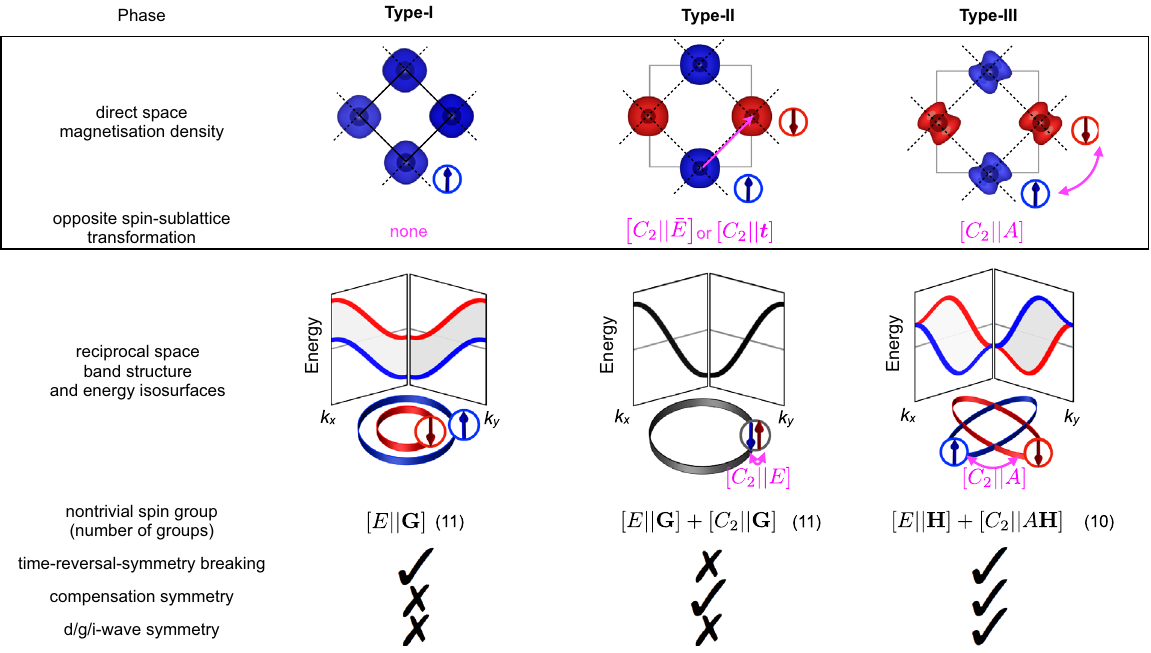
FIG. 1. Illustration (incolumns)ofthe three nonrelativisticcollinearmagneticphases.Topbox:Illustrative collinearspinarrangementsand magnetization densities on crystals. Opposite spin directions are depicted byblue and red color. Spin arrows are placed outside the real-space cartoons to highlight that the overall spin axis orientation is not related to the real space coordinates for the nonrelativistic spin-group symmetries. 1st magnetic phase (conventional ferromagnetism) crystal corresponds to Fe, 2nd magnetic phase (conventional antiferromag- netism) to MnPt, and the 3rd unconventional magnetic phase (altermagnetism) to RuO 2 . Magenta arrow and magenta label highlight opposite-spin-sublattice transformation symmetries characteristic of the 2nd magnetic phase (real-space translation or inversion) and the 3rd magnetic phase (real-space rotation). Bottom box: Cartoons of band-structures and corresponding energy iso-surfaces show ferromagnetically spin-split bands (opposite spin states depicted by blue and red color), a spin-degenerate antiferromagnetic band, and bands in the 3rd magnetic phasewith alternating sign of the spin splitting. The opposite-spinsublattice transformation of the spin Laue group whichmapsthesame-energyeigenstateswithopposite spins onthesame k -vector inthe 2ndmagnetic phase andondifferent k -vectors inthe 3rd magnetic phase is again highlighted. The remaining rows give the spin Laue group structure for the given phase with the number of different groups in brackets, and presence/absence of time-reversal-symmetry breaking, compensation and d -, g -, and i -wave